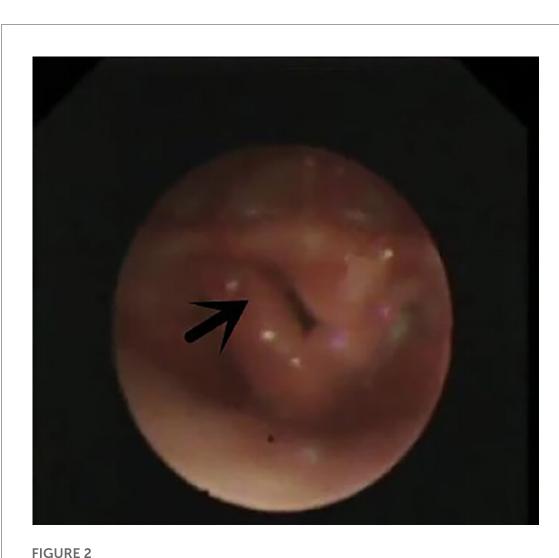
FIGURE2 Laryngomalacia. Arrow indicates both sides of epiglottis cartilage curl inward and throat cavity.